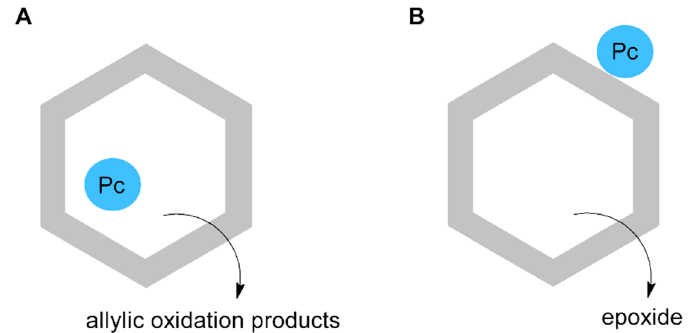
Figure 4. Direction of the oxidation reactions depending on the porphyrin location: inside the pores of support ( A ) and deposited on the external surface ( B ) [60]. of support ( A ) and deposited on the external surface ( B )